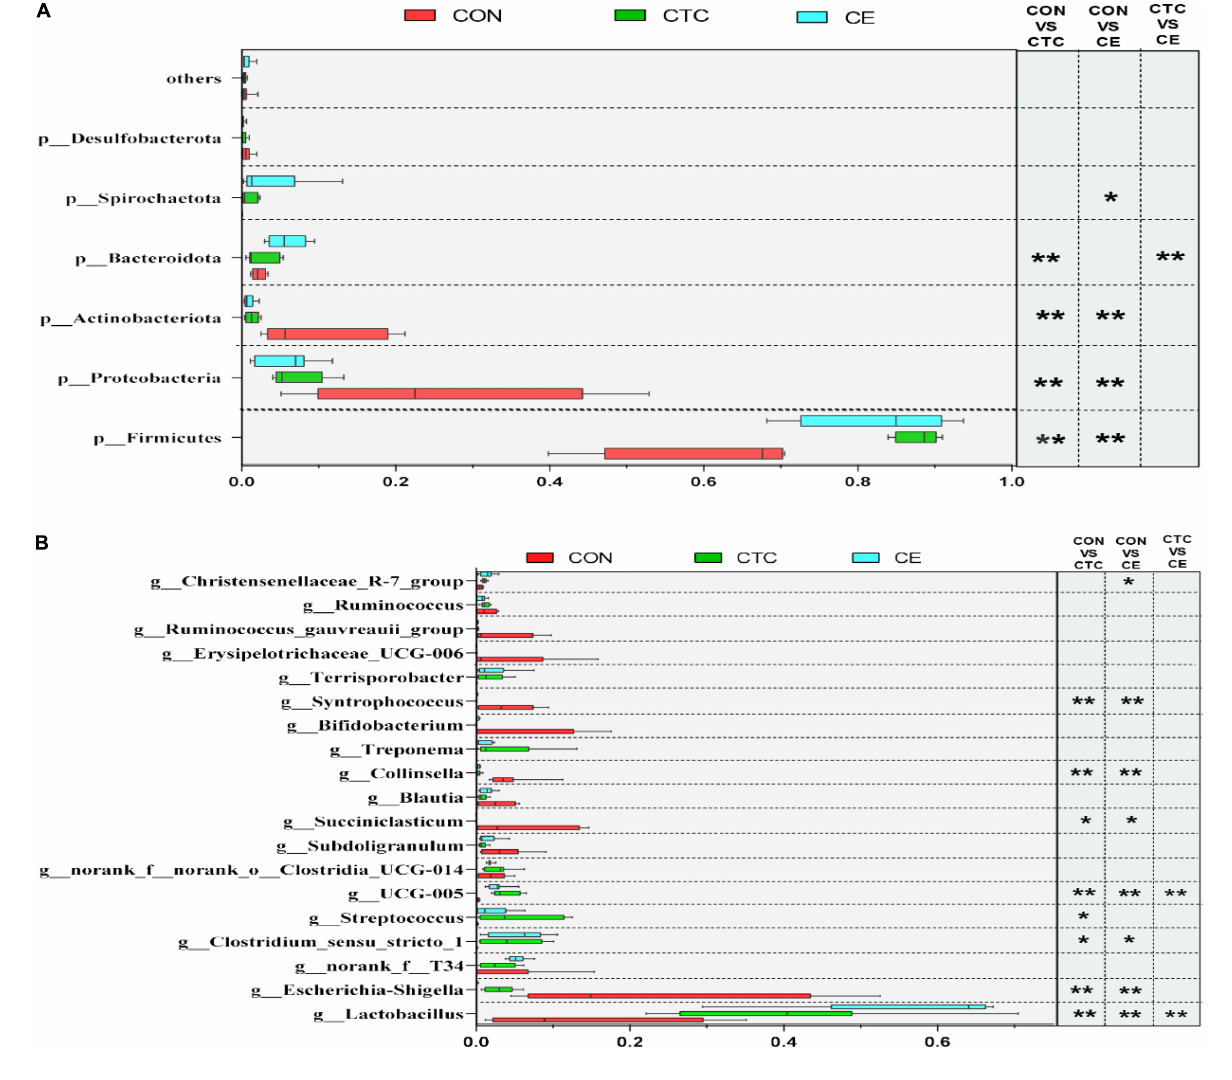
FIGURE 2 | Different microbiota comparison by the Student’s t -test on phylum (A) and genus (B) of cecum. LEfSe analysis showed significantly changed bacteria between CON, CE, and CTC group. The individual minipig was regarded as the experimental unit ( n = 8). CE, compund enzyme group; CON, basal diet group; CTC, chlortetracycline group. * p < 0.05 and ** p < 0.01 represent significant difference,